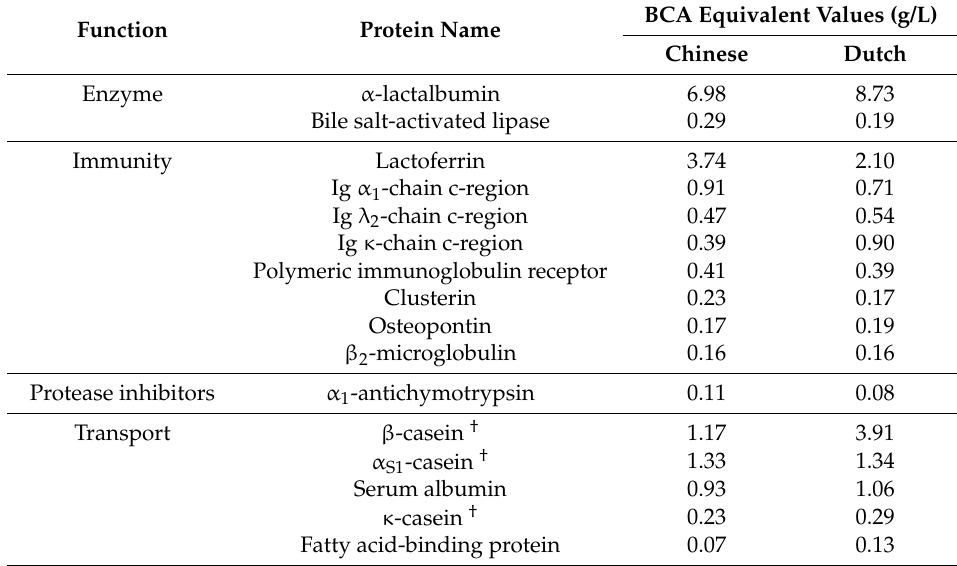
Table 1. The 15 most abundant serum proteins categorized per function in both Chinese and Dutch human milk during lactation, with their corresponding BCA equivalent values (g/L) values at week 1.